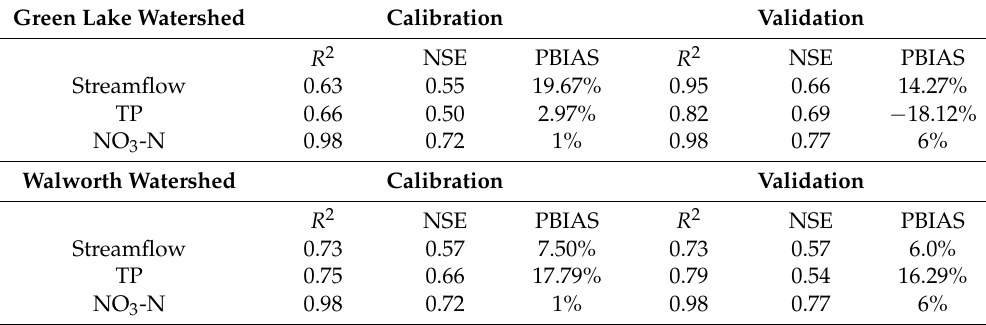
Table 2. Simulation performance metrics for streamflow, and total phosphorus for the Water Erosion Prediction Project-Water Quality (WEPP-WQ) model